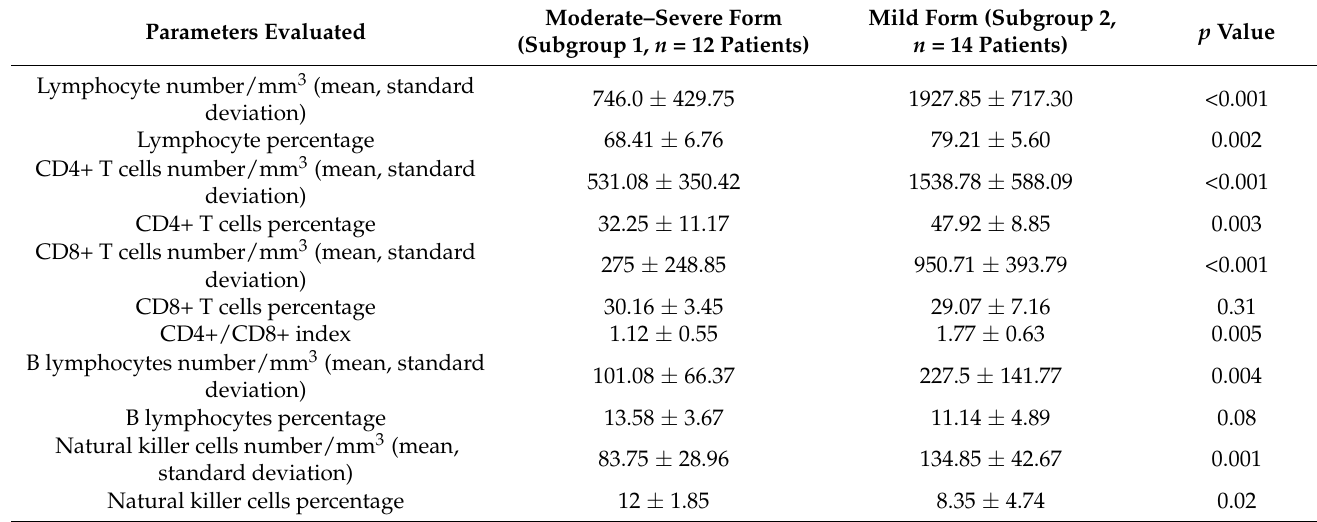
Table legend: OR—odds ratio; CI—confidence interval. Table 5. Univariate analysis of lymphocyte populations among the evaluated